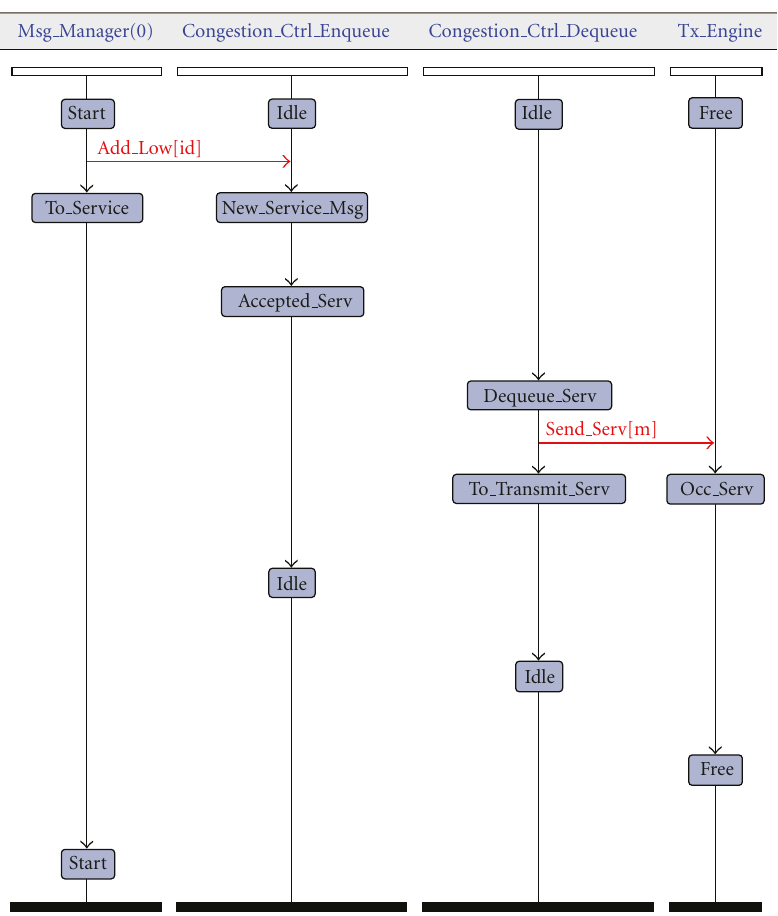
Figure 10: Service Packet Sending